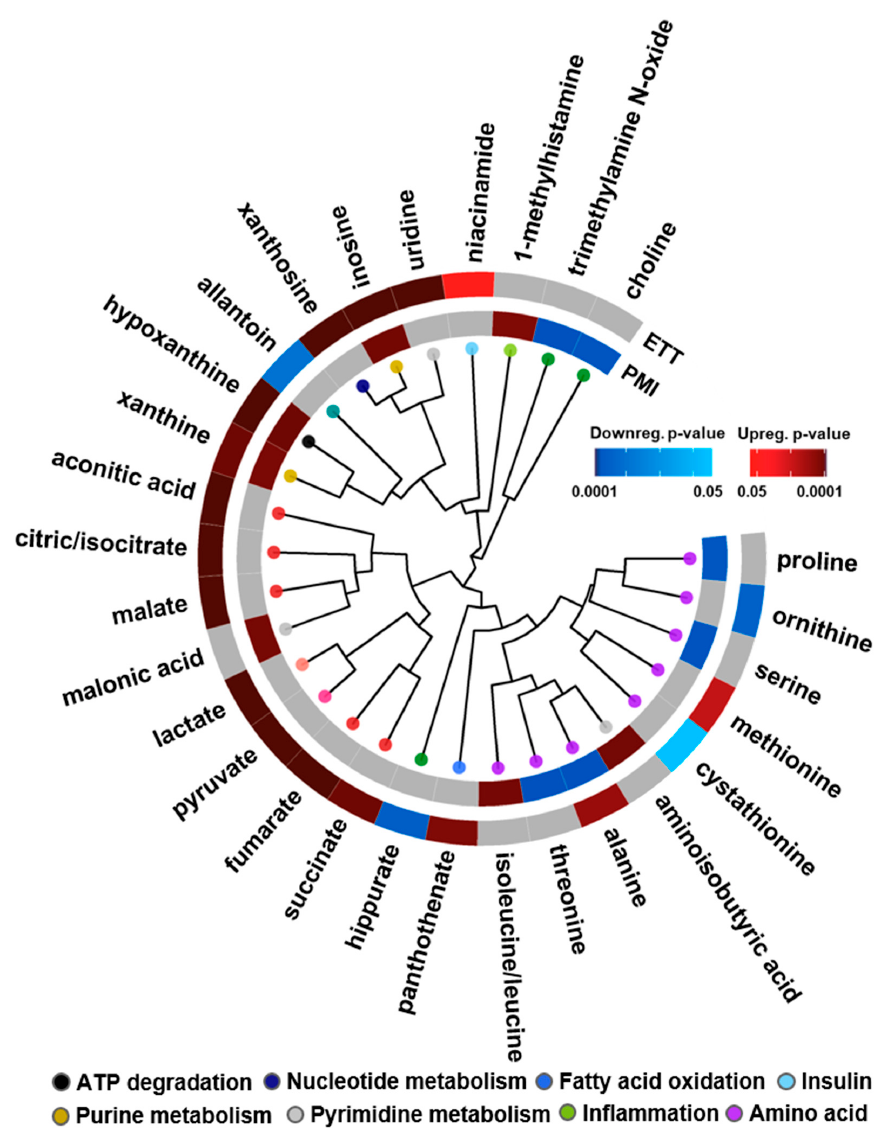
Figure 4. Statistically significant metabolites in the ETT and PMI studies. A circular dendrogram is utilized to showcase the differentially expressed metabolites in the PMI (inner ring) and ETT (outer ring) cohorts. Red and blue are used for up- and downregulation with a color gradient visualizing the magnitude of the adjusted p -value observed. Grey metabolites were detected but not statistically significant.